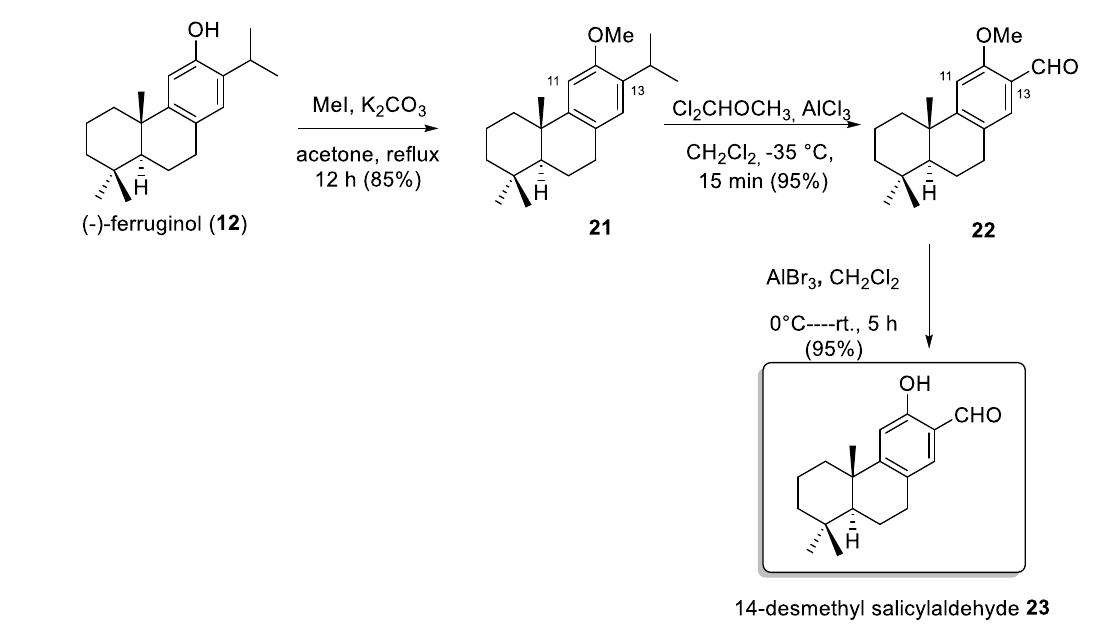
Scheme 4. Synthesis of 14-demethyl salicylaldehyde 23 from (-)-ferruginol ( 12